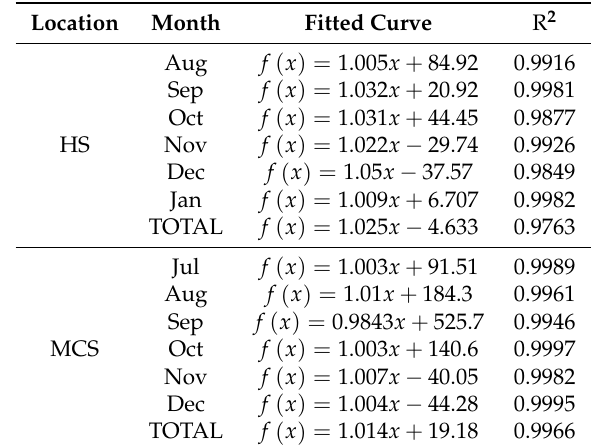
Table 8. The monthly and total fitted curve characteristic equation and determination coefficient values of estimation for both